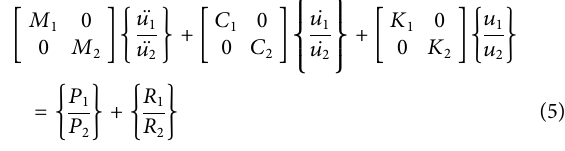
FIGURE 4 Coef fi cient of friction measurement results. (A) SRV test bench. (B) Test result.